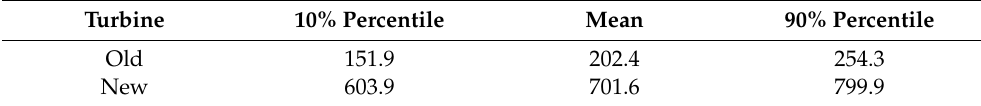
Table 12. NPV(k € ) per MW of installed